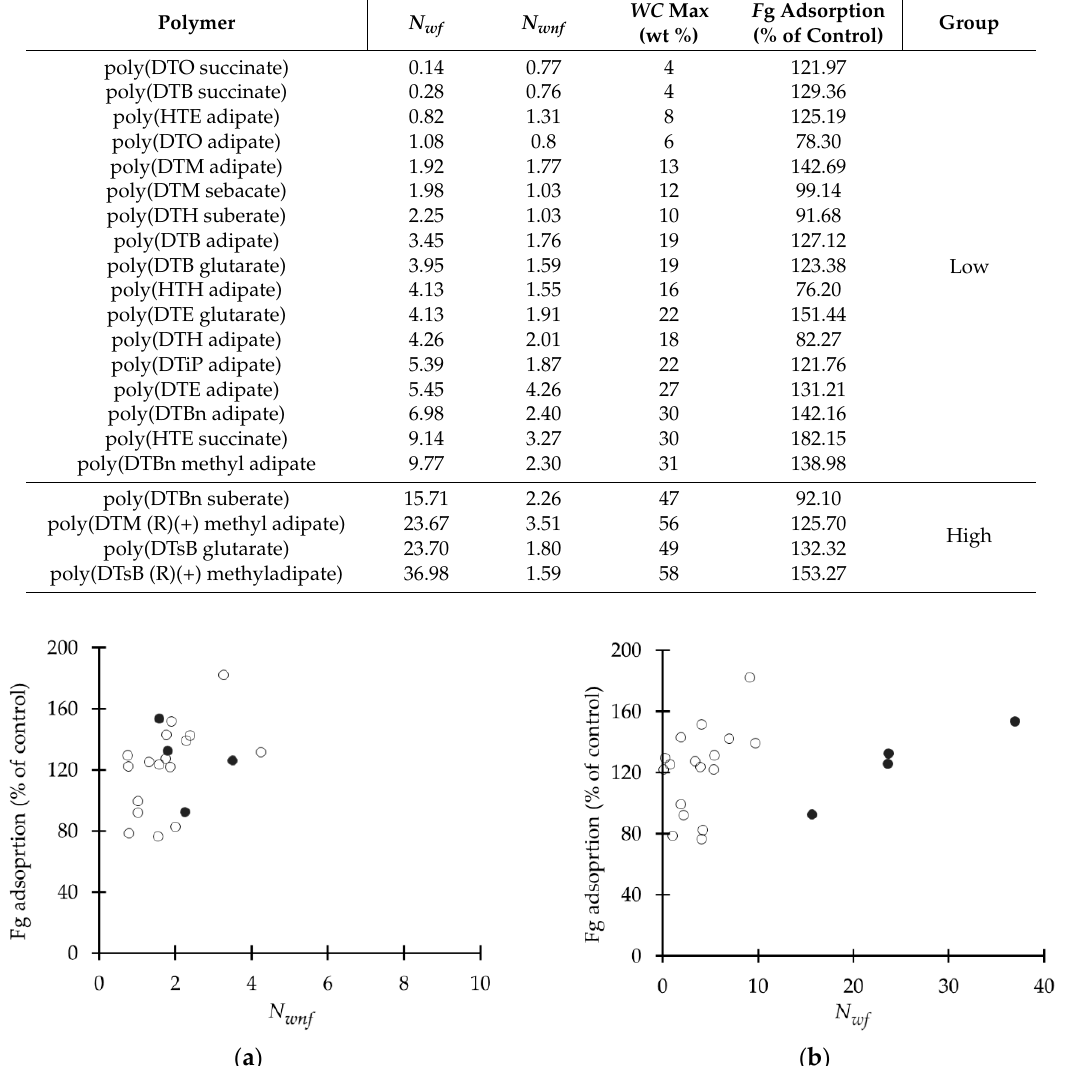
Table 2. Data of each polyarylate measured and calculated from [45,46]. Fibrinogen ( F g) adsorption data extracted from [44].